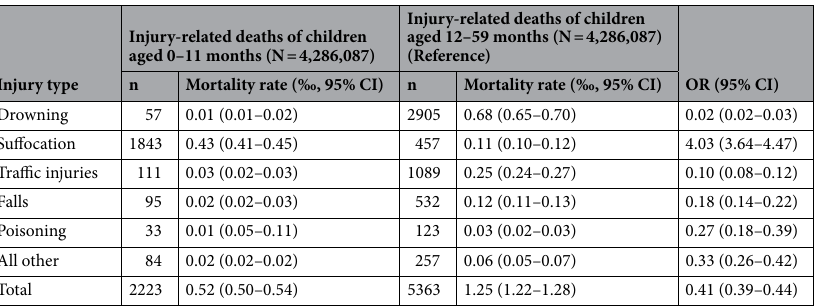
Table 4. Injury-related under-five mortality rate by age. N number of live births, OR crude odds ratio, CI confidence interval.